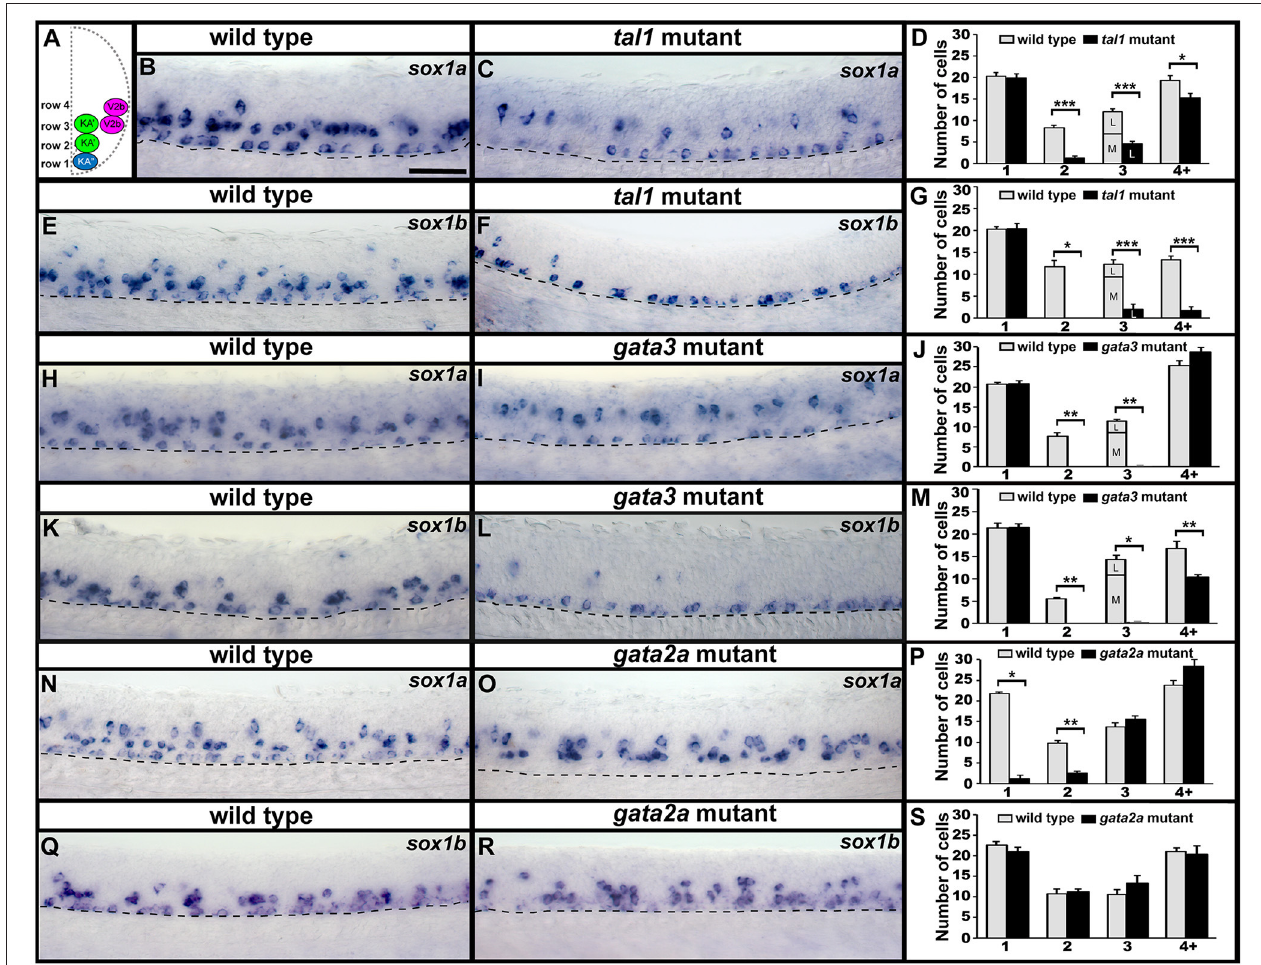
FIGURE 5 | Expression of sox1a and sox1b in tal1 , gata3, and gata2a mutants. (A) Cross-sectional schematic indicating positions of KA ′′ , KA ′ , and V2b neurons. Lateral views of sox1a and sox1b expression in 24h WT sibling (B,E,H,K,N,Q) and tal1 (C,F) , g ata3 (I,L), and gata2a (O,R) mutants. Dorsal, top; anterior, left. Dashed lines indicate ventral limit of spinal cord. Scale bar = 50 microns. Mean number of cells expressing sox1a (D,J,P) or sox1b (G,M,S) in each D/V row of spinal cord region adjacent to somites 6–10 in WT and mutant embryos. For tal1 and gata3 mutant results (D,G,J,M) the approximate proportions of medial and lateral row 3 cells are indicated by horizontal lines separating the number of medially-located cells (bottom and indicated with an “M”) from the number of laterally-located cells (top and indicated with a “L”). All of the remaining row 3 cells in these mutants are lateral, consistent with them being V2b cells. All counts are an average of at least 4 embryos. Error bars indicate SEM. Statistically significant comparisons are indicated with brackets and stars. *** P < 0.001, ** P < 0.01, * P < 0.05. For P- values see Supplementary Table